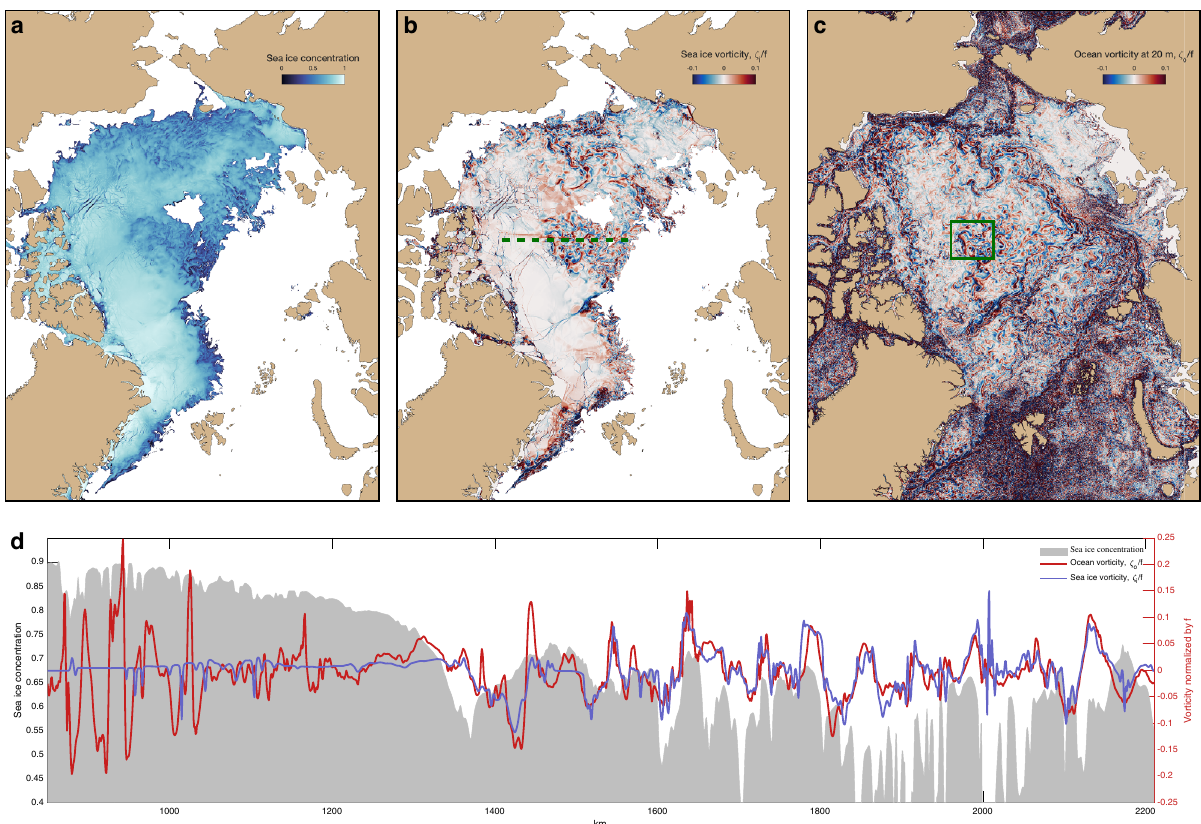
Fig. 1 State of the sea ice in the Arctic on July 20th, 2012, as simulated by the high-resolution global ocean model. a Distribution of the effective sea ice concentration, b sea ice vorticity ζ i normalized by the Coriolis parameter f , and c ocean vorticity ζ o at 20 m depth normalized by f ; all panels show non- dimensional quantities. White regions in a , b correspond to the ice-free ocean. The green square in c denotes a 400 by 400 km sub-domain used in the subsequent Fig. 3. d Sea-ice and ocean properties along the transect across a MIZ (green dashed line in b ); gray shading denotes sea ice concentration (left y axis), sea ice and upper-ocean vorticity are shown by blue and red curves, respectively (right y axis). Note the strong correlation between the sea ice and ocean vorticity emerging at low sea ice